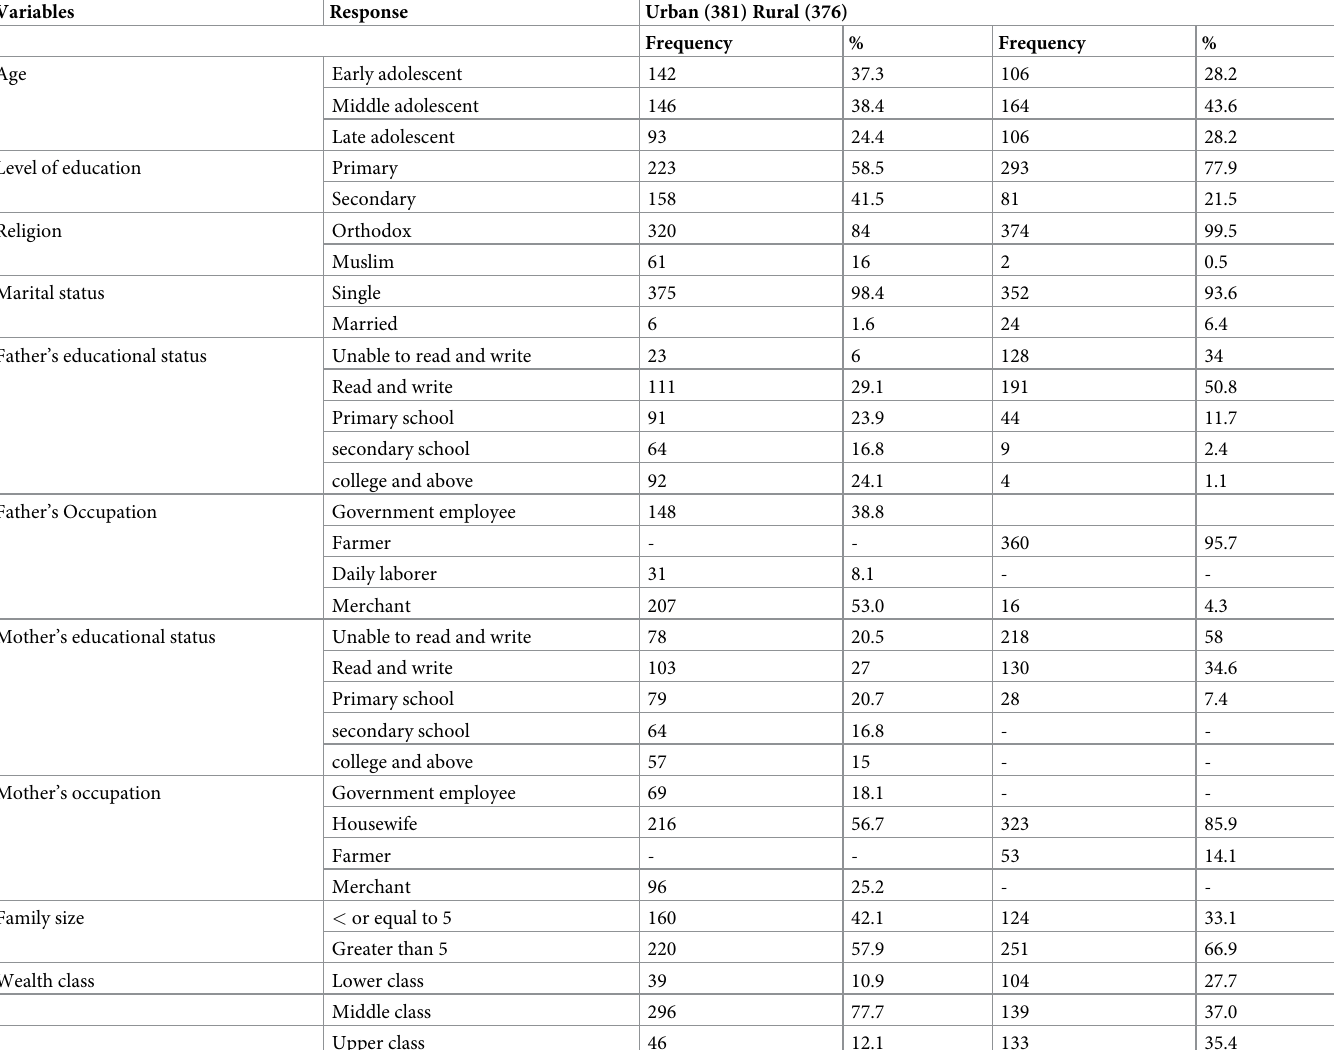
Table 1. Socio-demographic characteristics among school adolescent girls in Debark district, 2020 (n = 757).